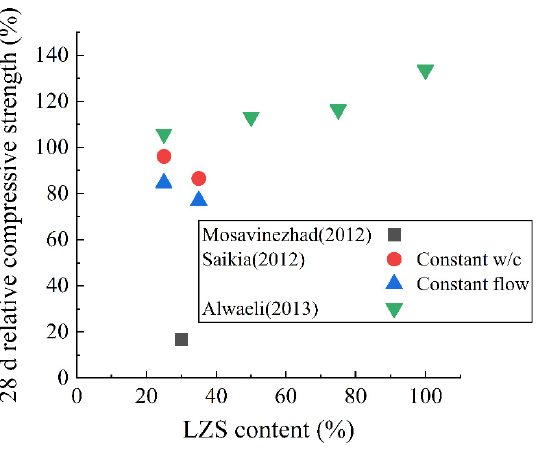
Figure 11. The 28 d relative compressive strength of hardened paste containing LZS aggregate [46,88,89].